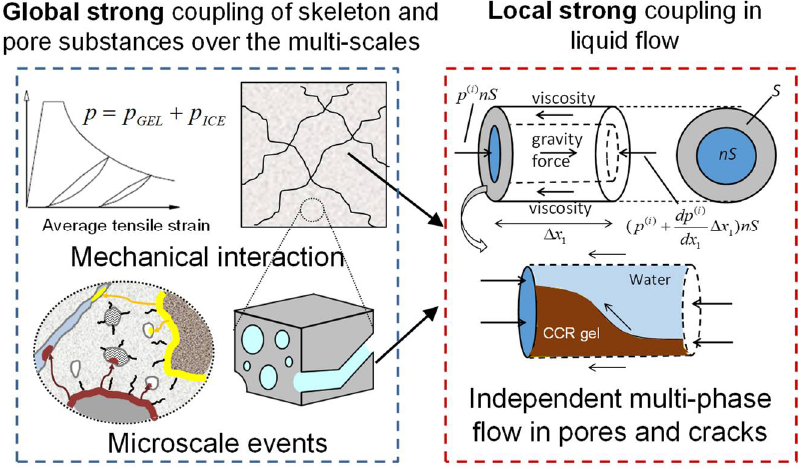
Figure 3. Liquid-phase corrosion product transport-cracking coupling mechanism based on pore mechanics.